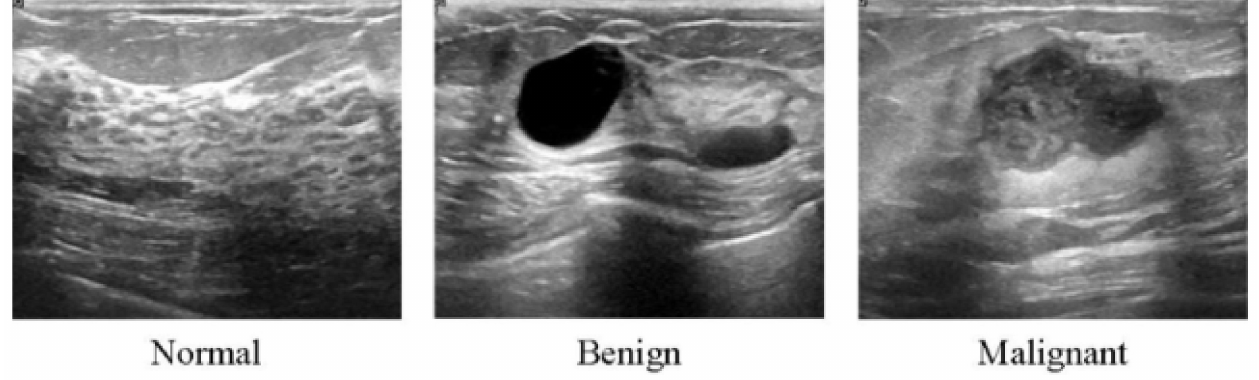
Figure 3. Ultrasound images from breast tissue for normal, benign, and malignant